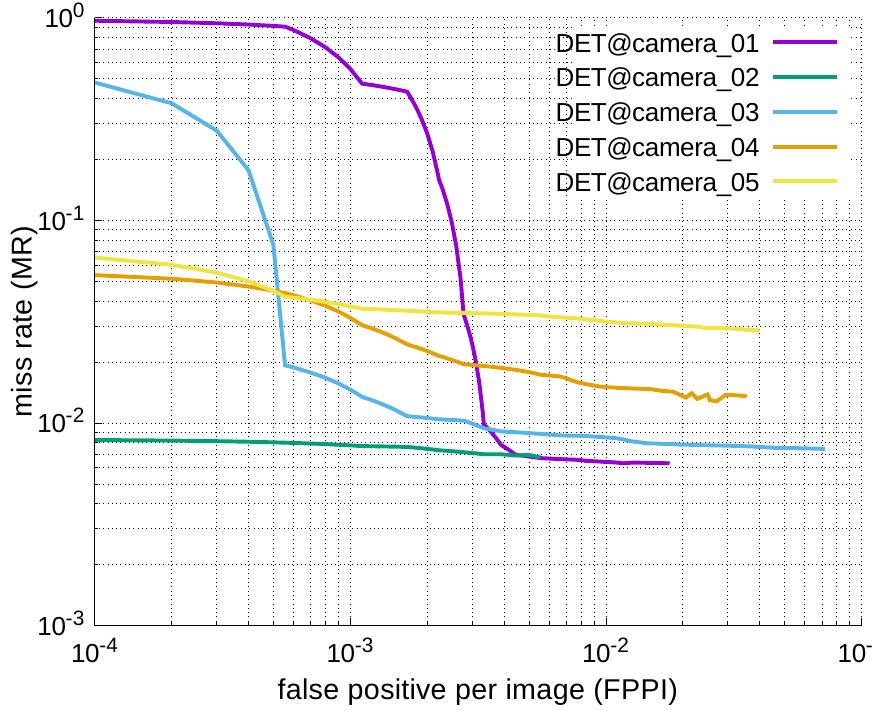
Figure 16. DET curves @ Cameras_01–05, informed-filters.